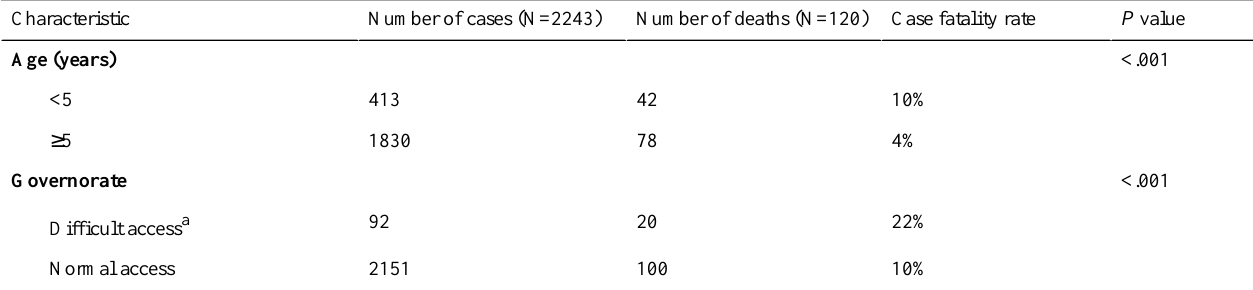
Table 2. Diphtheria case fatality rate by age and governorate in Yemen from 2017 to 2018.